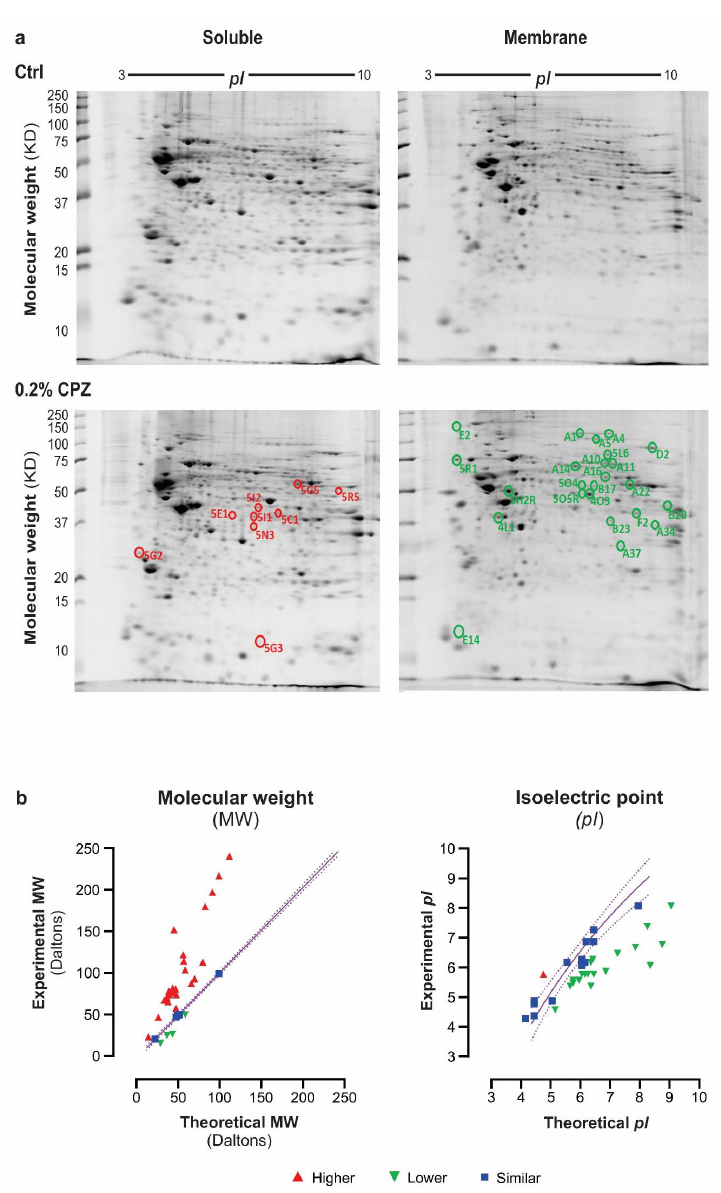
Figure 4. Top-down proteomic analysis. ( a ) Representative two-dimensional gel images of soluble (SP) and membrane (MP) brain proteomes from naïve Ctrl and 0.2% CPZ-fed groups used to detect proteoform changes. Proteoforms were resolved on the basis of their isoelectric point ( pI ) and molecular weight (MW). The total number of spots across different groups at both 5 and 12 weeks is given in Supplementary Table S1. Delta 2D software analysis revealed 33 unique spots for which the spot volume changed by at least 1.5-fold in at least one experimental group; soluble proteoforms are indicated by red circles and membrane proteoforms by green circles. The identities of the protein species are shown in Table 1 ( n = 15 gels / fraction, n = 5 animals / fraction, 5-week study n = 180 gels and 12-week study n = 120 gels). ( b ) Comparison between theoreticalandexperimentalMW(left)and pI (right)ofidentifiedproteoforms. Redrepresentsincrease, green decrease and blue indicates no statistically significant difference between the experimental and theoretical values. Purple dashed lines indicate 95% confidence intervals and the solid line represents full agreement between experimental and theoretical